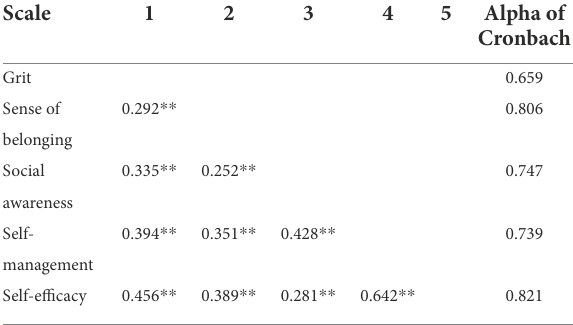
TABLE 3 Correlations between scales.